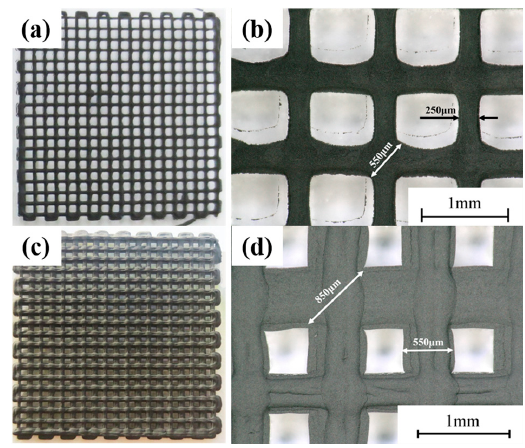
Figure 7. Comparison of LTDW printed patterns and room temperature printed patterns: ( a ) LTDW printed patterns; ( b ) the printing accuracy of LTDW printed patterns; ( c ) room temperature printed patterns; ( d ) the printing accuracy of room temperature printed patterns.